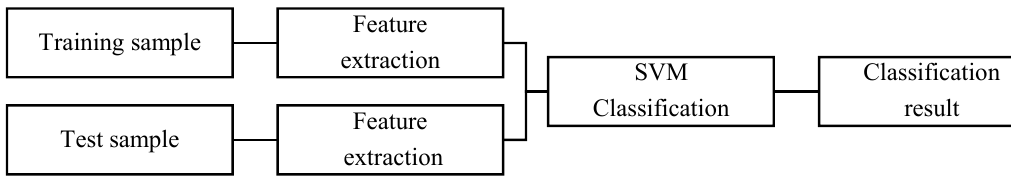
Figure 13. Feature extraction based on support vector machine (SVM).